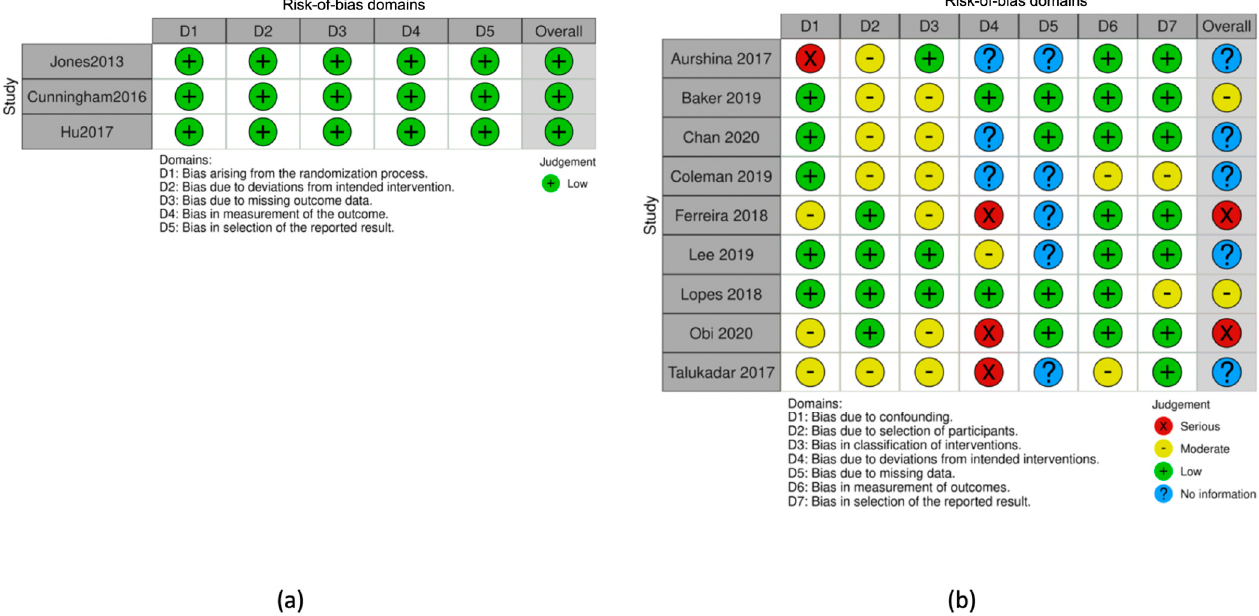
Figure 1. Risk-of-bias assessment and overall risk of each type of bias using ( a ) Cochrane Collaboration tool in RCTs and ( b ) ROBINS-I tool in observational prognostic studies.